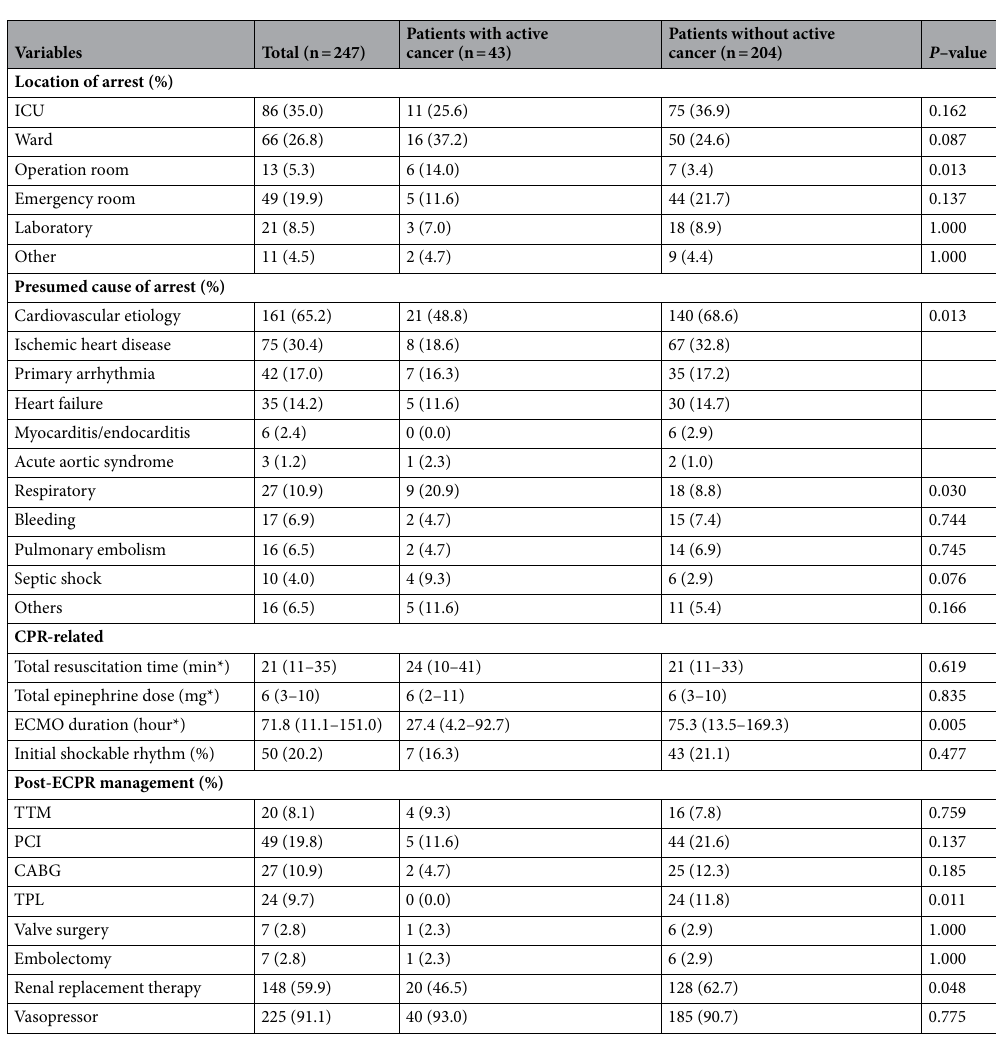
Table 2. ECPR-related variables. ICU Intensive care unit, ECMO Extracorporeal membrane oxygenation, TTM Targeted temperature management, PCI Percutaneous coronary intervention, CABG Coronary artery bypass graft, TPL Transplantation. *Median (interquartile range), otherwise mean